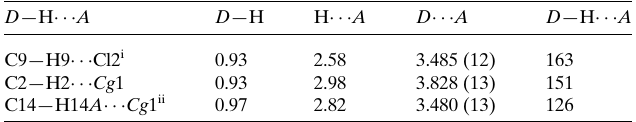
Table 1 Hydrogen-bond geometry (A˚ , (cid:4) ).